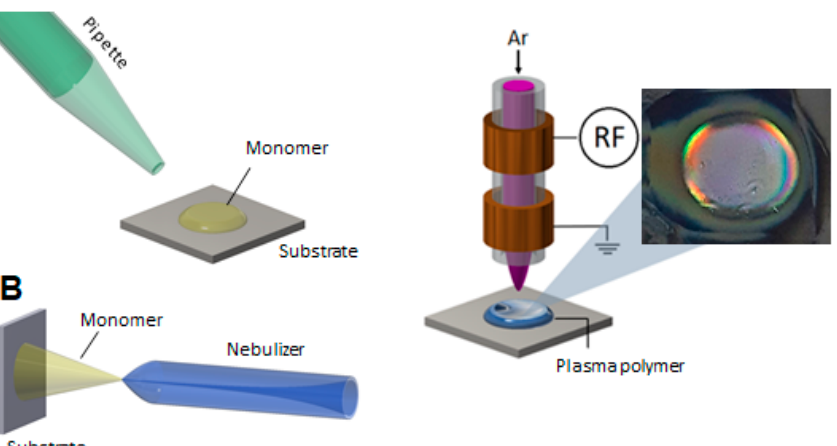
Figure 10. Schemes of two setups used for the synthesis of hydrogel films of different thickness (( A ): droplet method, ( B ): nebulizer method) and of the atmospheric-pressure plasma jet applied for the polymerization of (p(HEMA-co-DEAEMA) films, and a photograph of a pp hydrogel film. According to the methodology applied, the obtained films are referred to as d-HD or n-HD when the droplet (d) or nebulizer (n) setup was used.